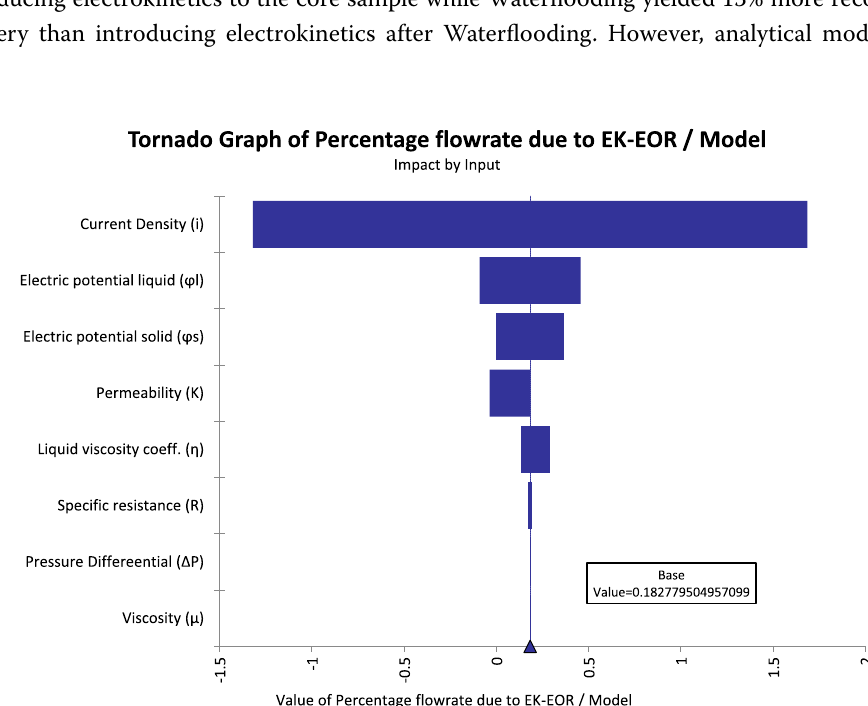
Fig. 11 Ranking of factors affecting performance of EK-EOR